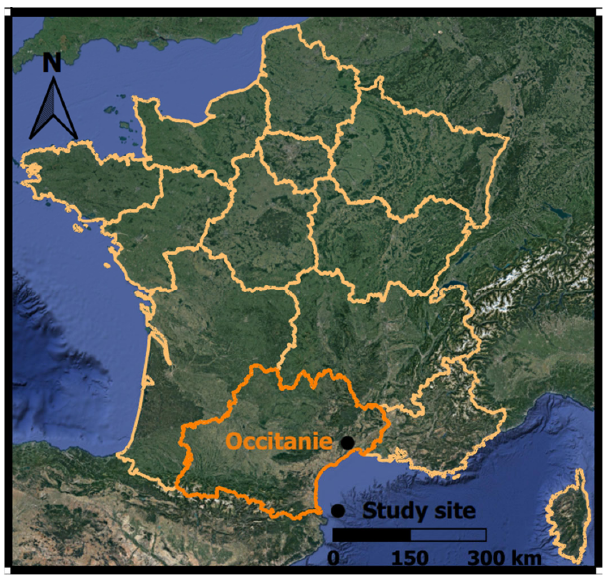
Figure 1. Location of the study site in France.